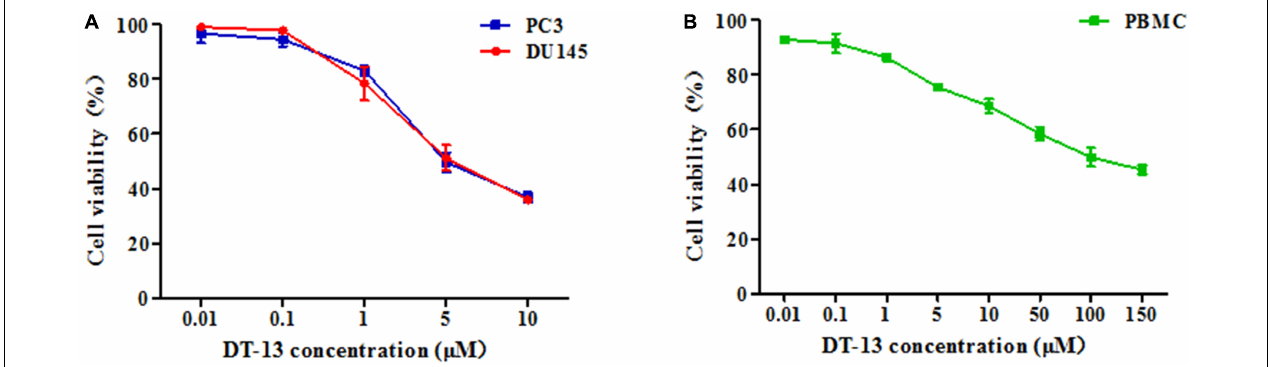
FIGURE 1 | Antiproliferative activities of DT-13 on prostate cancer cells and PBMC. Antiproliferative activities of indicated concentrations of DT-13 (0.01, 0.1, 1, 5, and 10 µ M) toward (A) PC3, DU145, and (B) PBMC were determined by MTT assay. Data are presented as mean ± SD, representative of three independent experiments.